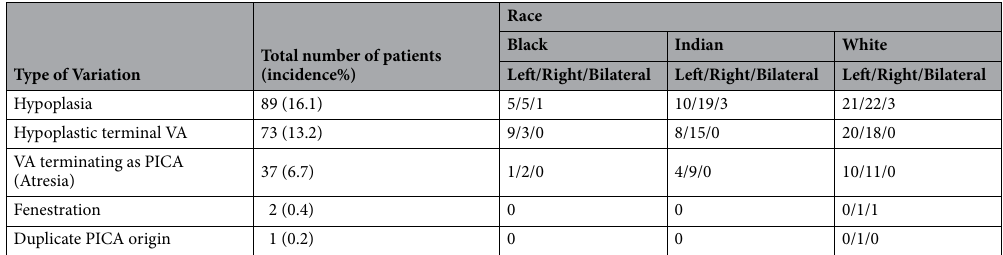
Table 2. Incidence of anatomical variations at the intracranial segment (V4) of the VA grouped according to race in South African patients.